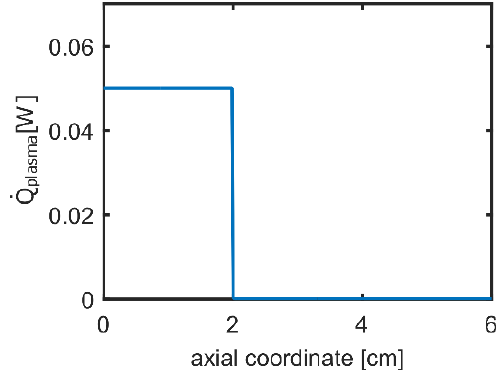
Figure 4. Plasma power deposition used for plug flow reactor (PFR) computations .